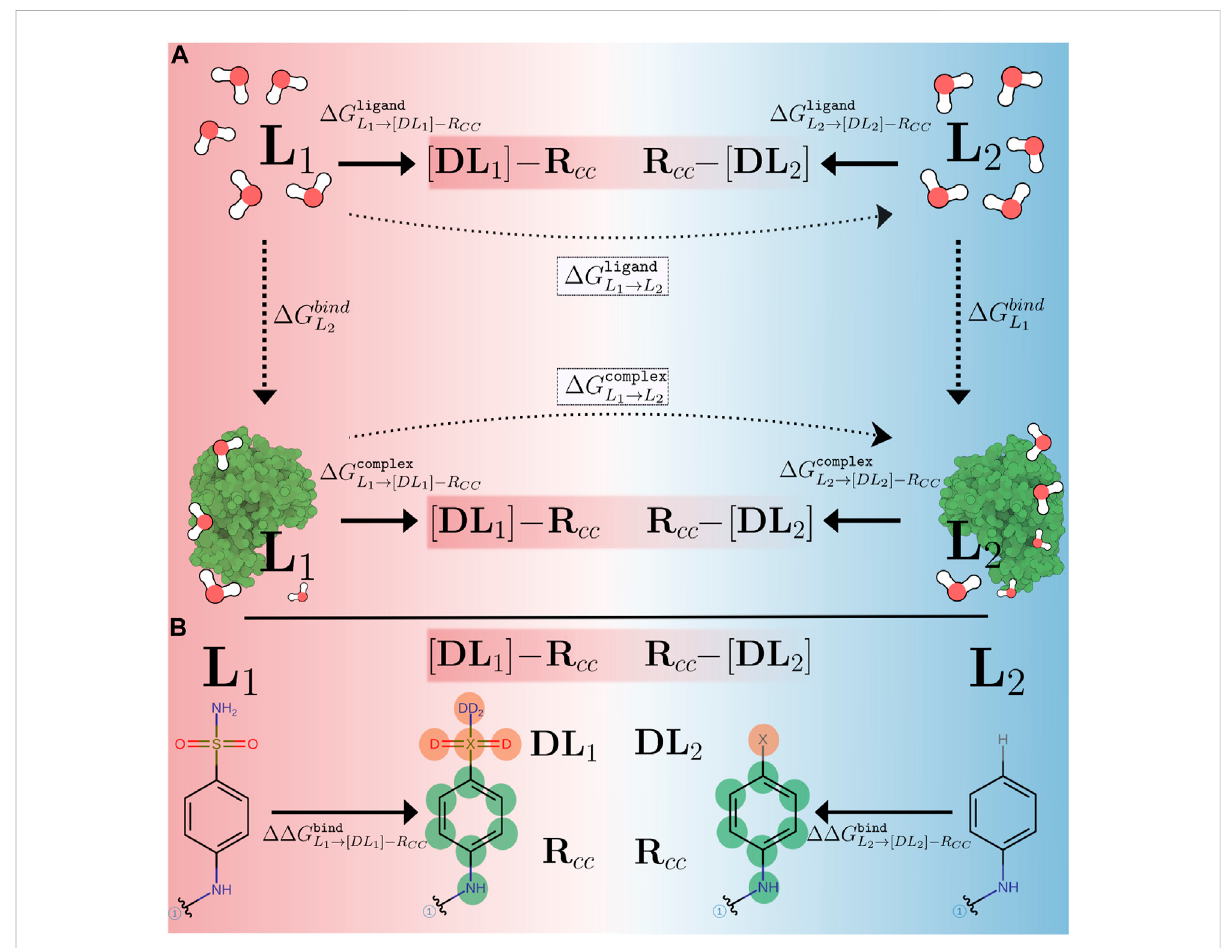
FIGURE 1 (A) Comparison of alchemical paths used in traditional setups (dotted, horizontal arrows) and in the CC/SAI approach (thick, horizontal arrows) implementedintransformatotocomputerelativebindingfreeenergydifferences.Freeenergiesarecalculatedrelativetonon-physicalintermediate states, the common core [DL i ]-R CC ( i = 1, 2), connecting the two ligands (L 1 , L 2 ). Here [DL i ] represents the atoms of each ligand not in the CC region and R CC indicates the CC region itself. (B) The mutation path for calculating ΔΔ G bind L between a pair of ligands taken from the CDK2 dataset. 1 → L 2 Theatomsthatdifferbetweenthetwoligandsand,thus,arenotpresentintheCC,arehighlightedincolor;thesearetransformedintodummyatoms (reddish circles). The common core is indicated by the green